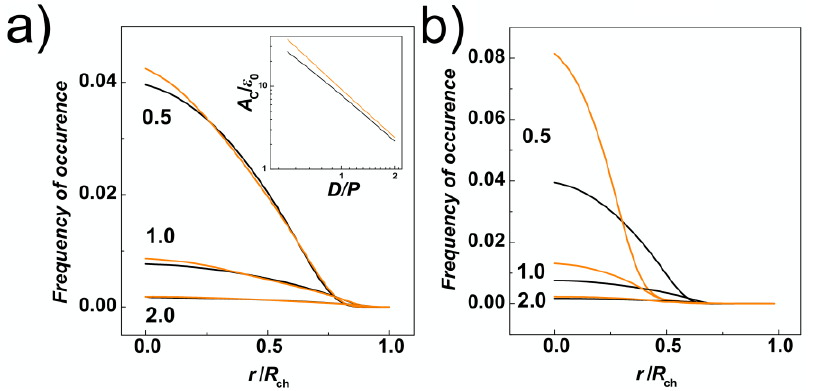
Figure 3. Radial distributions of DNA monomers obtained from simulations of DNA confined in nano-channels without external compressive force and calculated ( a ) from the centre of the nano- channel and ( b ) from the major axis of inertia of the channels in normalized radial coordinates, r / R ch . The values computed for cylindrical and helical geometries of the channels are shown in black and orange colours respectively. The numbers indicate regime of the confinement strength expressed as the ratio D / P . The inlay on the panel ( a ) shows also the dependence of the confinement free energy, A C , obtained as the integral of the monomer concentration on the surface of the channels [29].